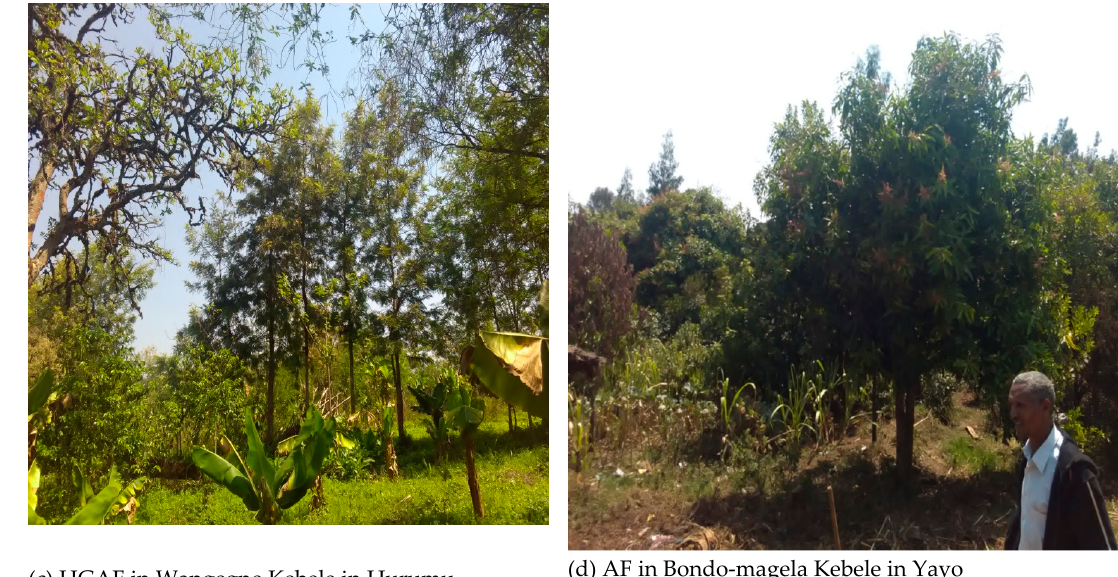
Figure 2. Sample Pictures illustrating Homegarden Agroforestry System in Yayo and Hurumu